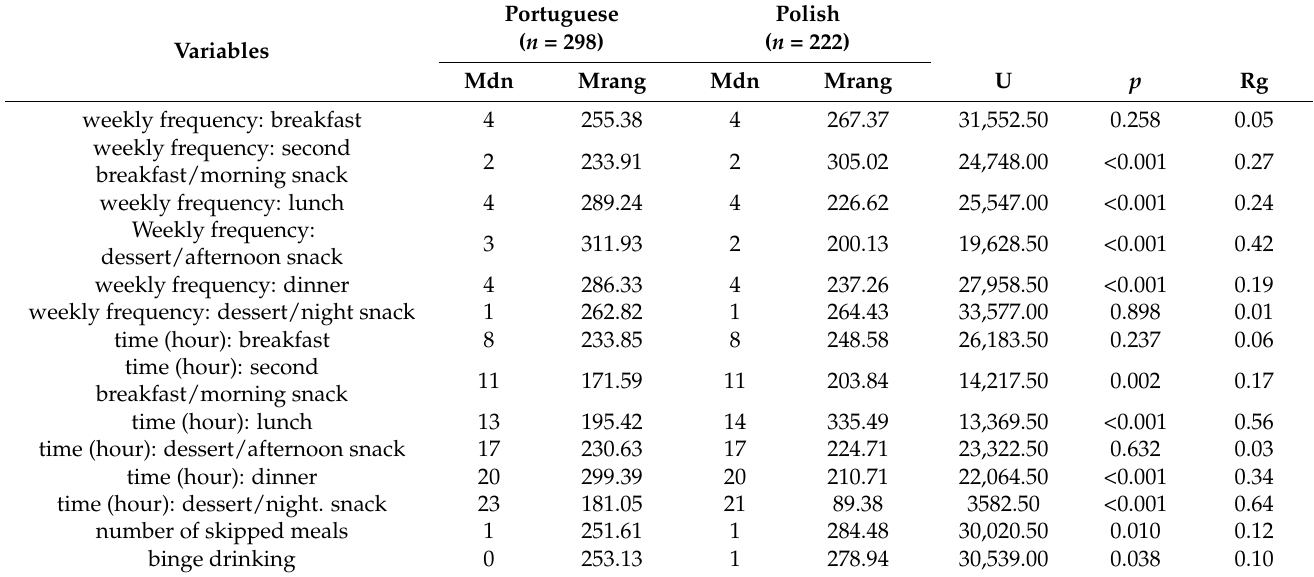
Table 6. Results of analysis using Mann–Whitney U test for study indicators by